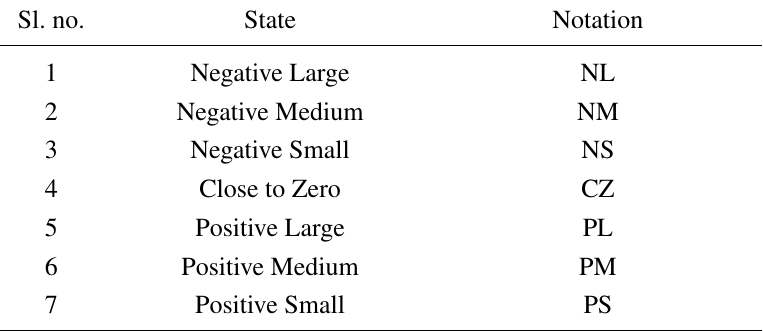
Table 3. Linguistic steps used to condition the